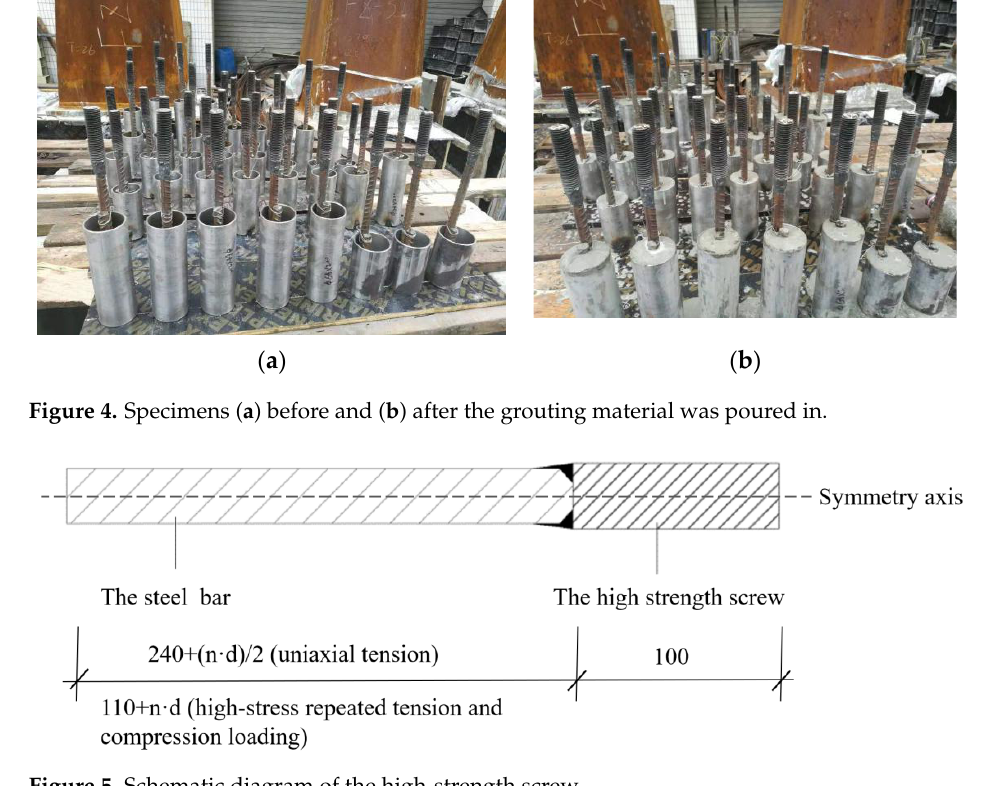
Figure 5. Schematic diagram of the high-strength screw.